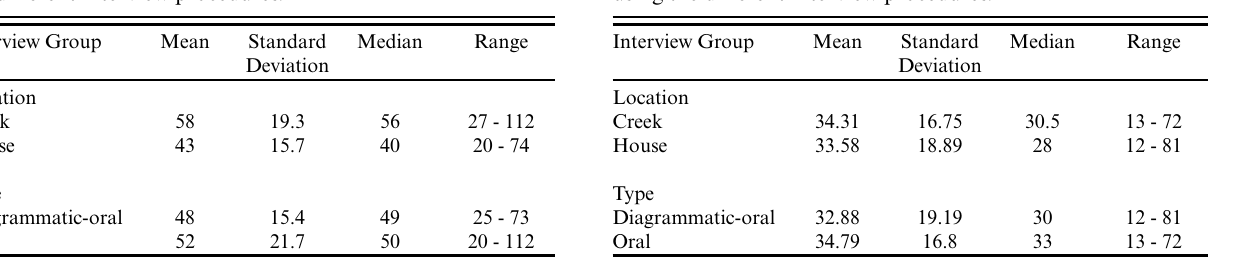
Table 1 . The mean and median number of concepts elicited using the different interview procedures.